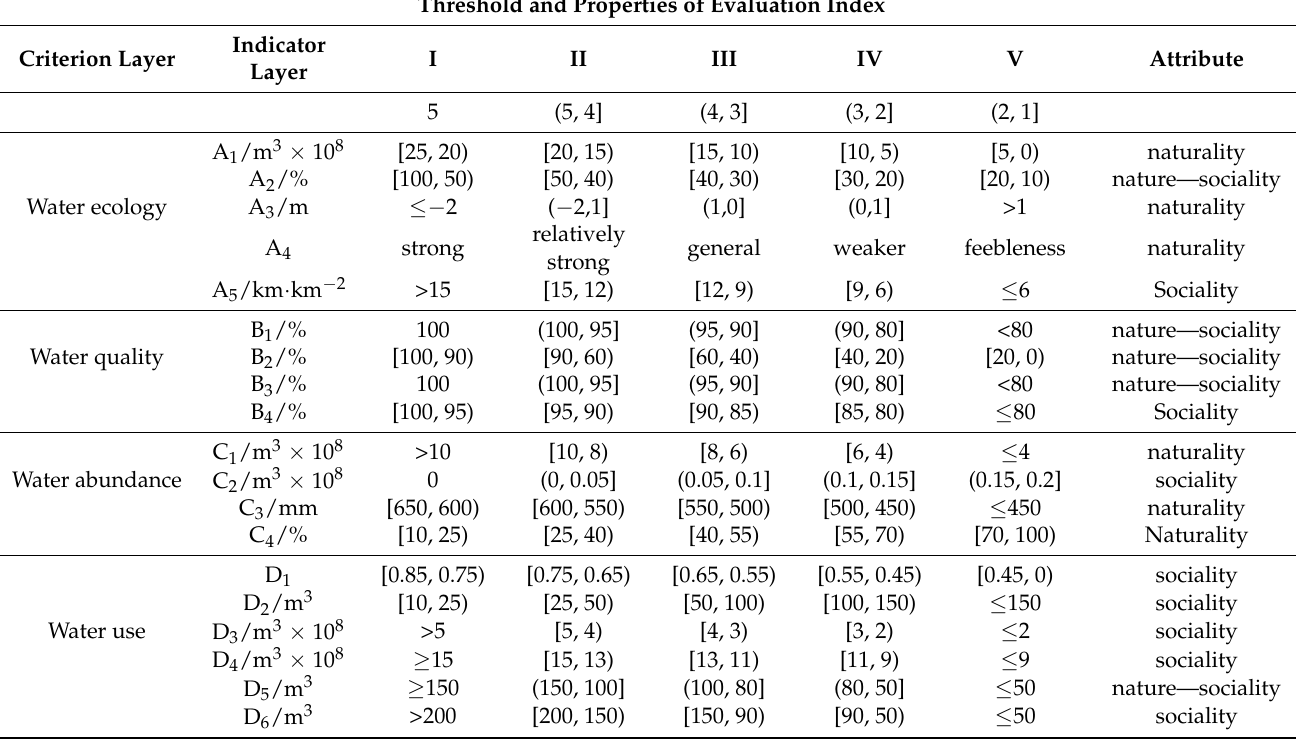
Table 1. Health evaluation of water cycle